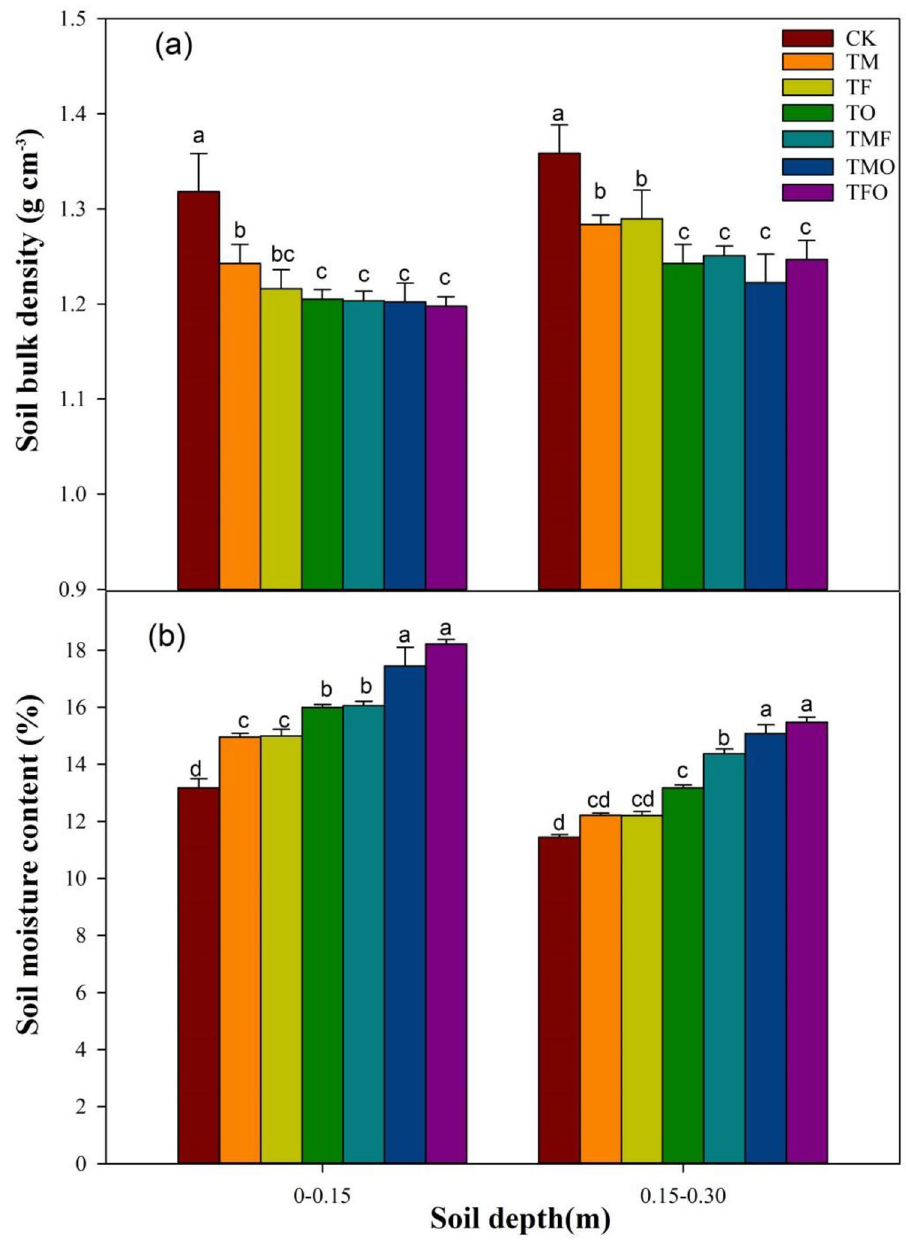
Figure 4. Effects of the application of different improved materials on BD and SMC. CK: no improved material; TM: maturing agent (ferrous sulfate); TF: fly ash; TO: organic fertilize; TMF: maturing agent + fly ash, TMO: maturing agent + organic fertilizer; TFO: fly ash + organic fertilizer; BD, soil bulk density; SMC, soil moisture content. Different lowercase letters represent significant differences among different improved material treatments in the same soil